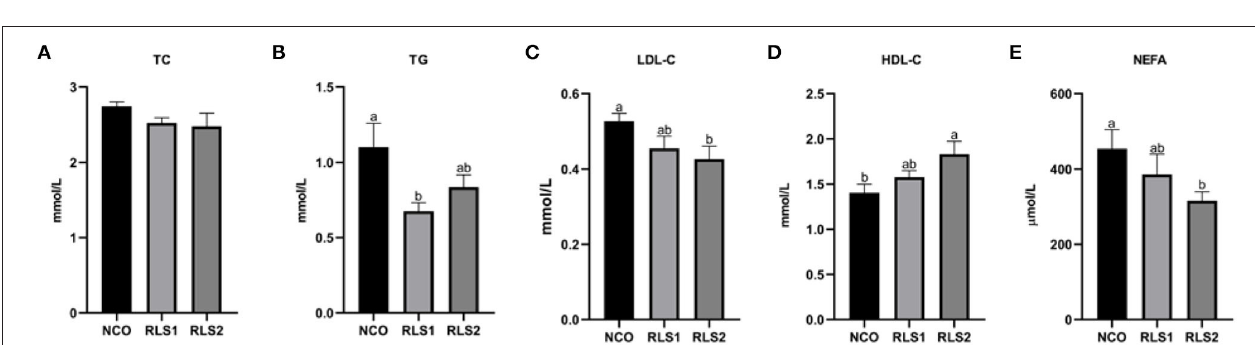
FIGURE 2 | Effects of RLS on serum lipid levels in rats. NCO, rats were gavage-fed normal saline; RLS1, rats were gavage-fed 50 mg/kg · bw RLS; RLS2, rats were gavage-fed 100 mg/kg · bw RLS. TC, total cholesterol; TG, triglyceride; LDL-C, low-density lipoprotein-cholesterol; HDL-C, high-density lipoprotein-cholesterol; NEFA, non-esterified fatty acid. Values are expressed as the mean ± SEM, n = 8. Different letters represent a significant difference of P < 0.05. Part labels represent standard error for the sample mean (SEM).